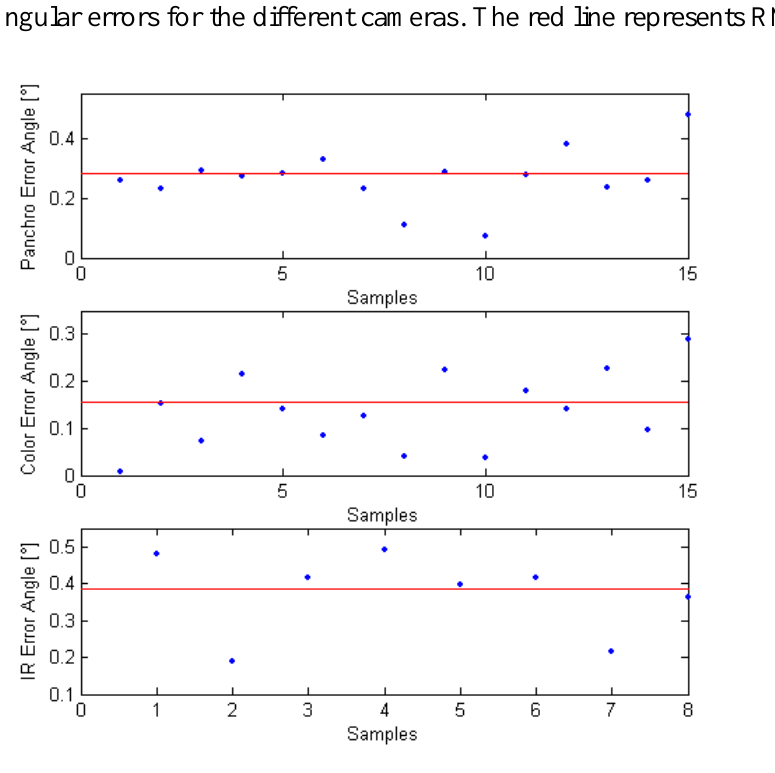
Figure 12. Angular errors for the different cameras. The red line represents RMS